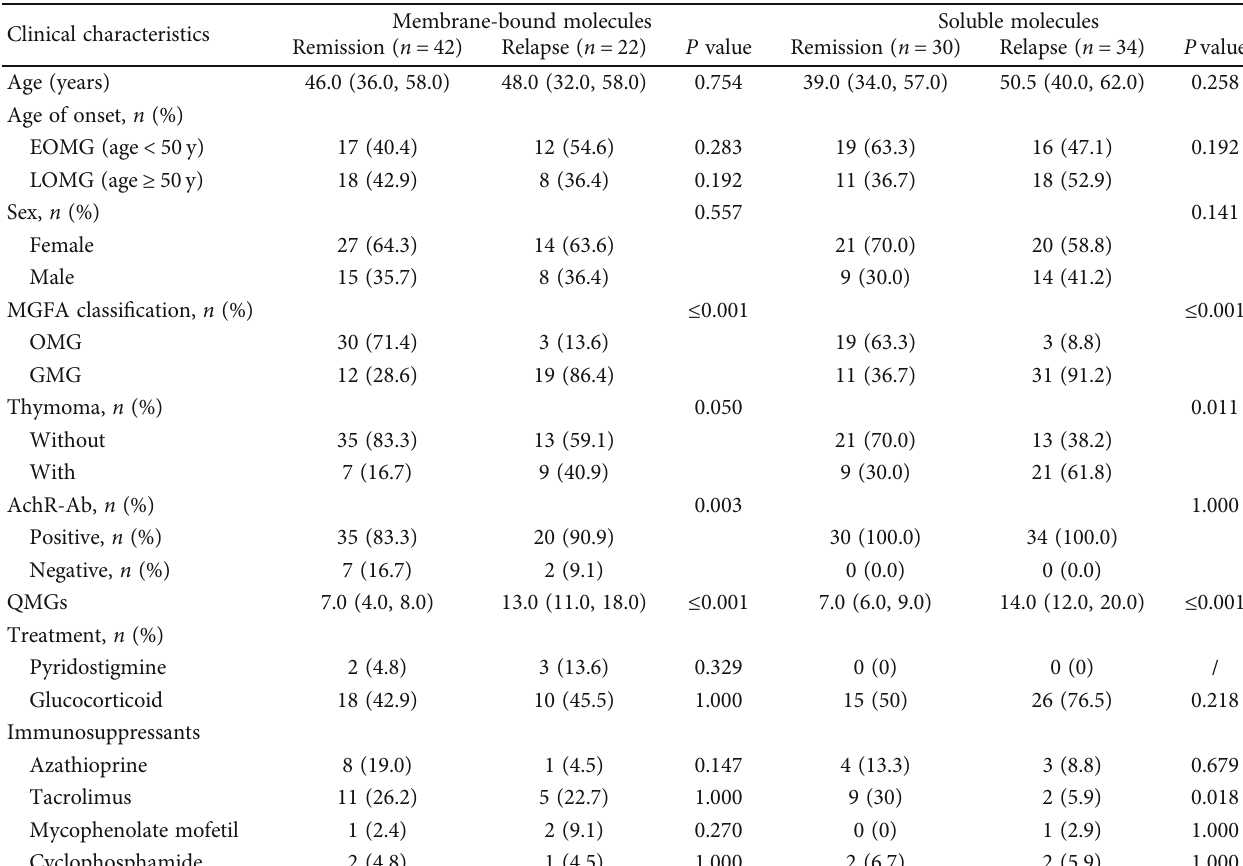
Table 6: Clinical characteristics of patients with MG in relapse and